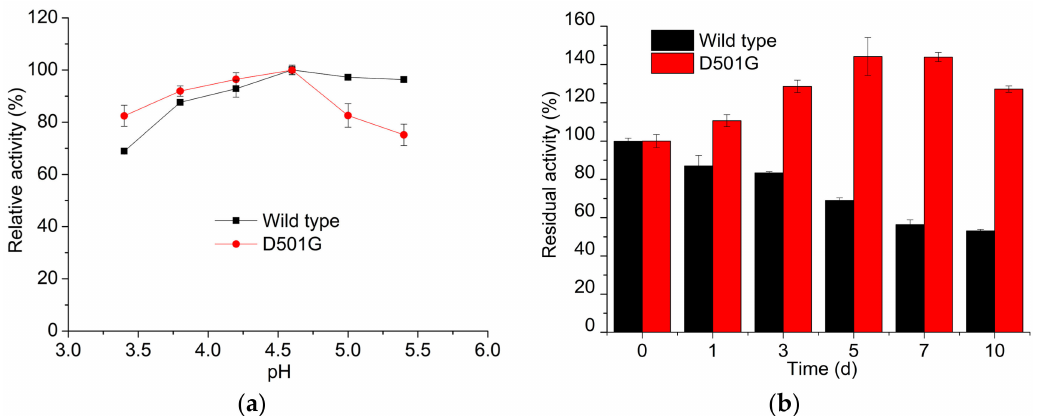
Figure 2. Effect of pH on activity ( a ) and stability ( b ) of the wild-type and D501G. ( a ) Laccase activity was measured with ABTS as a substrate; ( b ) the stability was tested at pH 9.0. Error bars represent the standard deviation of three replicates.